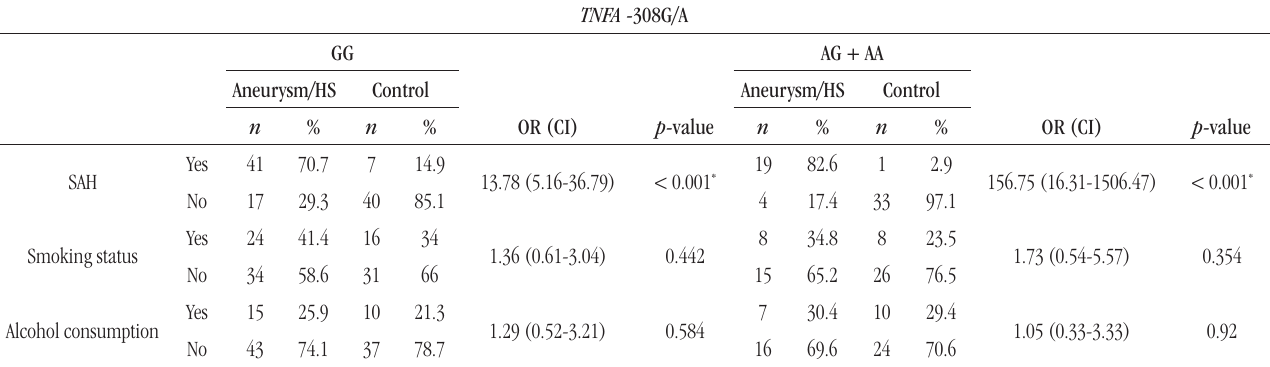
taBLE 3 − Clinical characteristics of case and control subjects